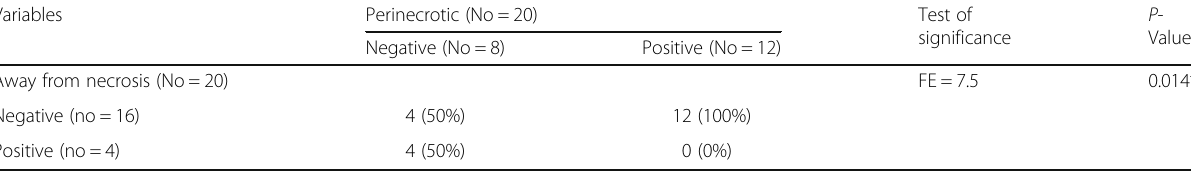
Table 4 Relationship between CAIX expression in malignant cells perinecrotic and away from necrosis Variables